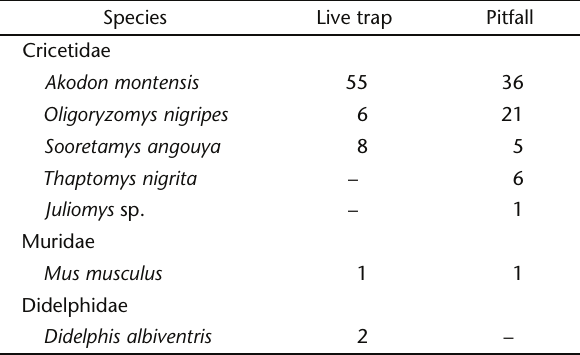
Table I. Small mammal species sampled and the number of captures in live traps and pitfall traps in the Morro do Elefante, municipality of Santa Maria, southern